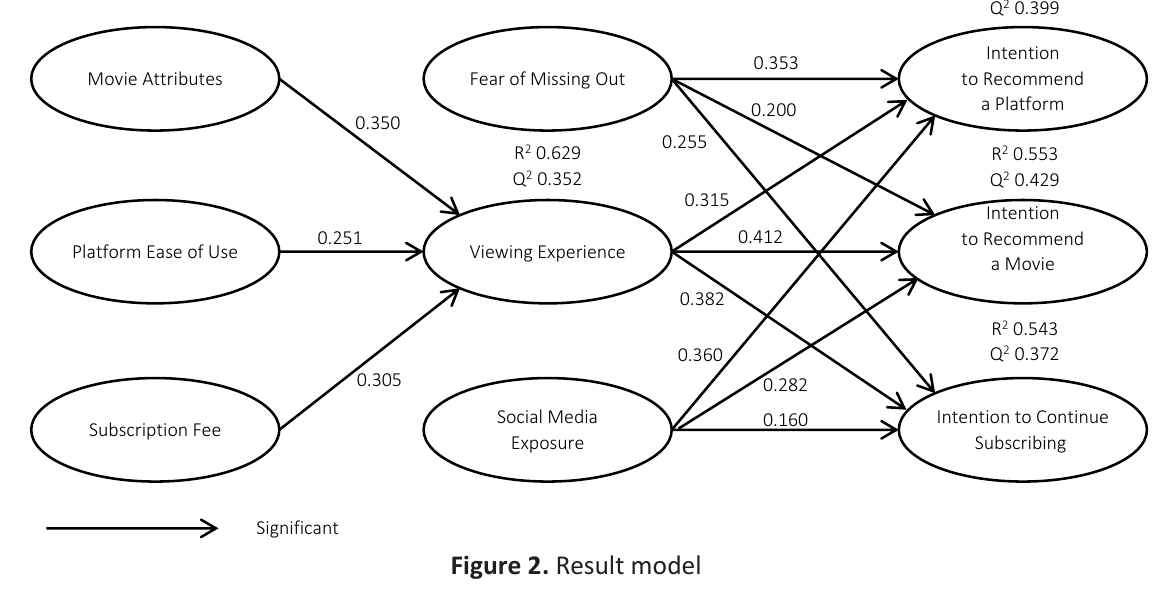
Figure 2. Result